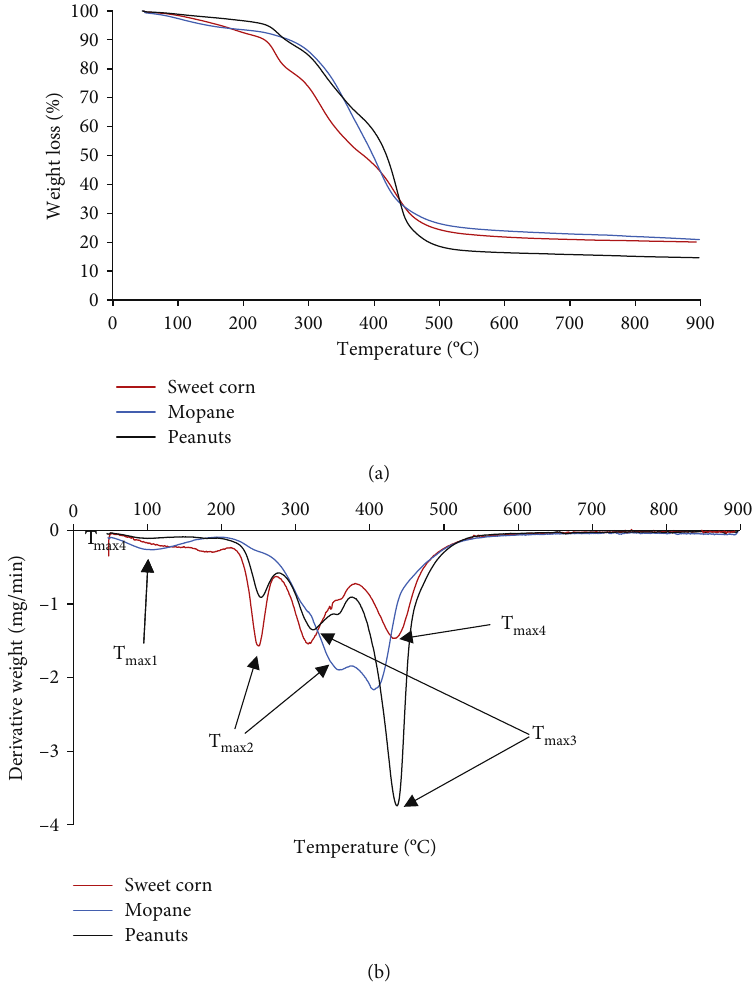
Figure 2: TGA and dTGA curves for sweet corn, mopane worms, and peanuts. Table 3: Summary of maximum degradation temperatures for mopane worms, sweet corn, and peanuts.